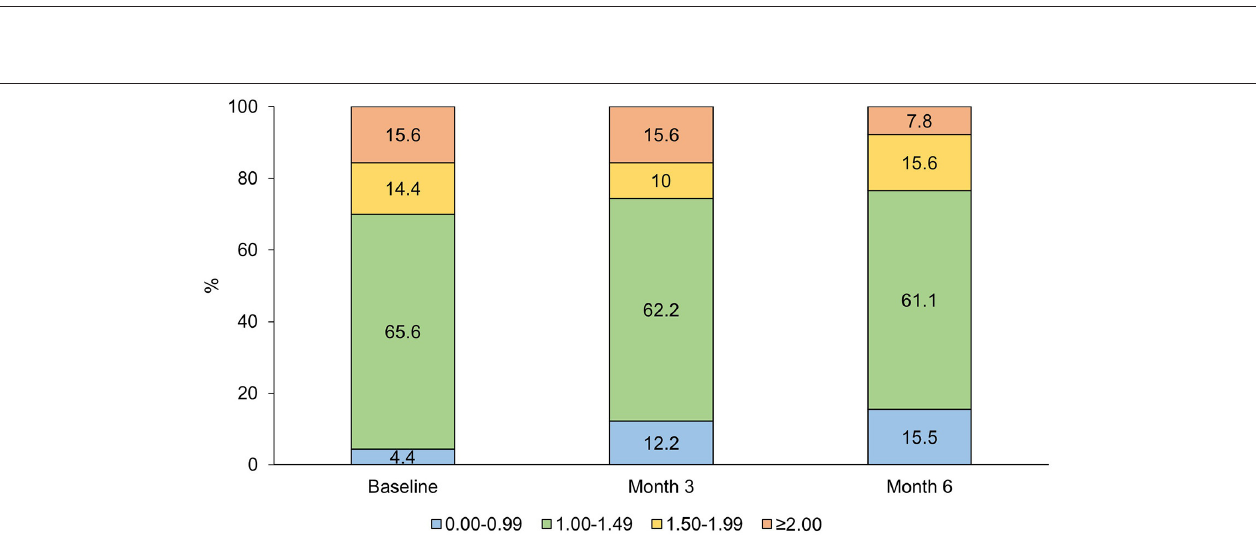
FIGURE 3 | Percent distribution of Migraine Medication Index categories at baseline, Month 3, and Month 6 ( p < 0.001 for distribution).